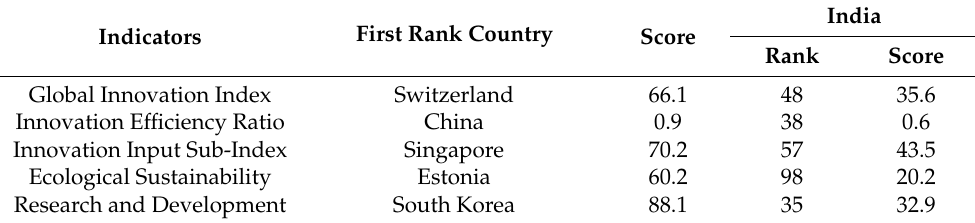
Table 7. India rank comparing with first rank country on innovation indicators.